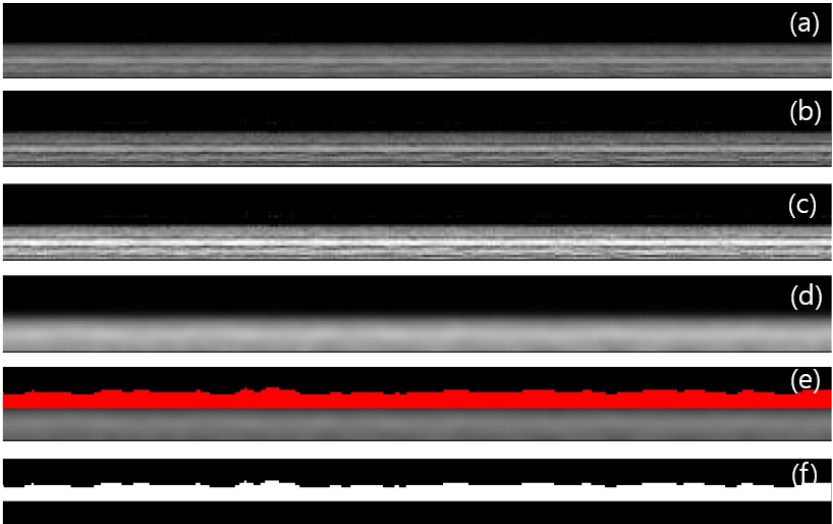
Figure 2. Example of image analysis for foulant layers on the membrane: ( a ) raw OCT image, ( b ) after Unsharp mask, ( c ) after contrast-limited adaptive histogram equalization (CLAHE), ( d ) after Gaussian blur, ( e ) thresholding image (red color is the foulant layer), and ( f ) fouling image (white color is the foulant layer).